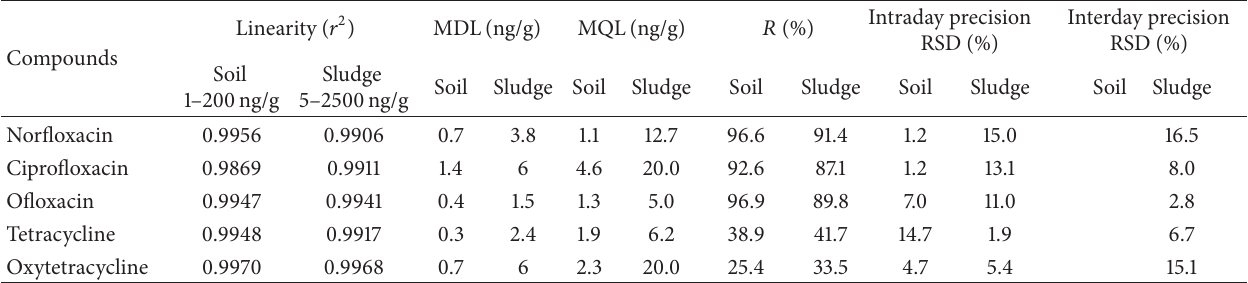
Table 3: Validation parameters: linearity, limits of detection and quantification (MDL and MQL), recoveries ( 𝑅 ), and precision (relative standard deviation, RSD) in soil and